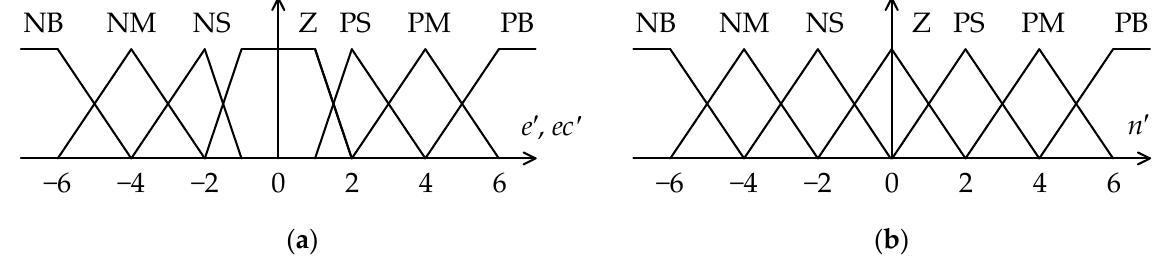
Figure 9. Member function of the fuzzy logic controller: ( a ) FLC1; ( b ) FLC2.